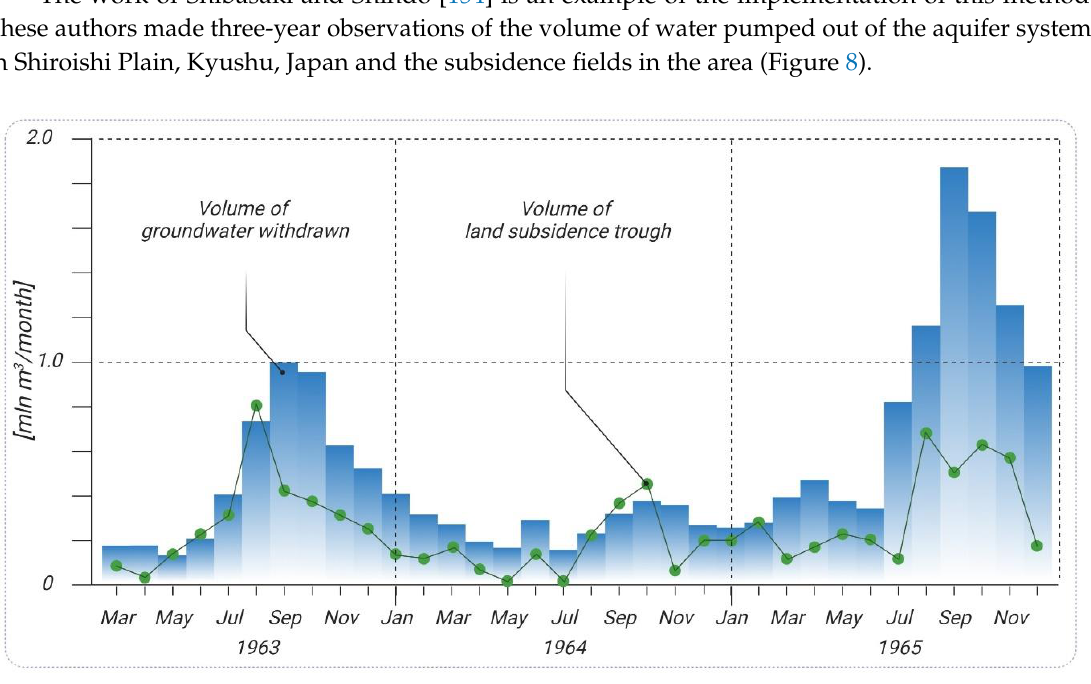
Figure 8. Change in groundwater volume withdrawn and land subsidence in the vicinity of Shiroishi Plain, Kyushu, Japan; modified after [154].